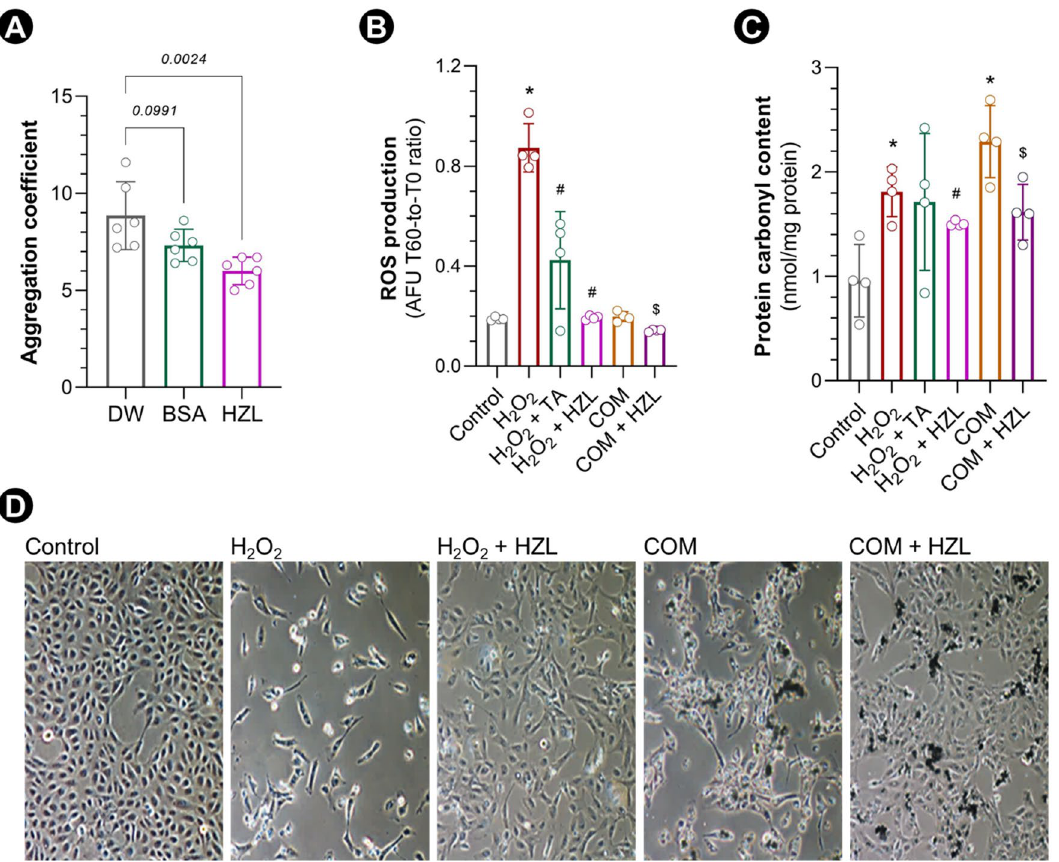
Figure 1. COM aggregation inhibition and oxidative stress mitigation by HydroZitLa. ( A ) HydroZitLa (HZL) significantly decreased aggregation of calcium oxalate monohydrate (COM) crystals compared with distilled water (DW) control. ( B ) H 2 O 2 (10 µM) significantly increased ROS generation in HK-2 cells compared with control. Co-treatments with tocopheryl acetate (TA, 300 µM) and HydroZitLa (10% v/v) significantly decreased ROS generation in HK-2 cells treated with H 2 O 2 . ( C ) Protein carbonyl contents in HK-2 cells treated with H 2 O 2 (1,000 µM) and COM (150 µg/cm 2 ) were significantly higher than that in control. HydroZitLa co-treatment significantly decreased levels of ROS generation and protein carbonyl content in HK-2 cells treated with H 2 O 2 and COM. ( D ) Representative micrographs showing reduction of cell survival and induction of morphological change in HK-2 cells treated with H 2 O 2 (1000 µM) and COM (black precipitates, 150 µg/cm 2 ). HydroZitLa co-treatment rescued cells from apoptosis as well as restored cell morphology and proliferation. * P < 0.05 vesrus Control, # P < 0.05 versus H 2 O 2 , $ P < 0.05 versus COM. Micrograph magnification: ×